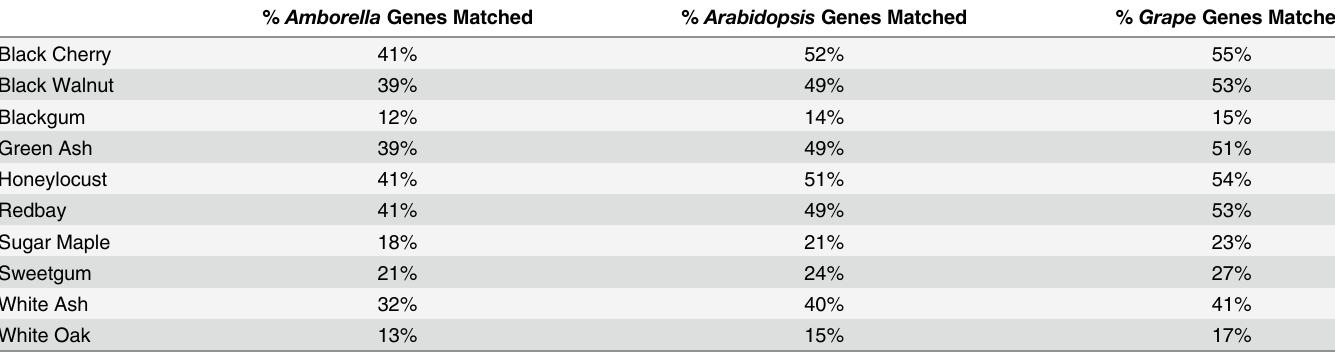
Table 4. Percent of genes represented in low coverage reconstructed fragments, based on comparison to three model plant species.